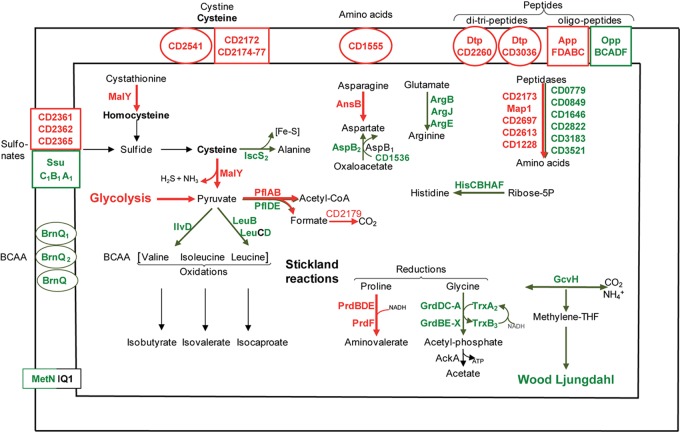
Amino acid transport and metabolism in biofilms compared to planktonic cultures. A model for amino acid transport and utilization pathways in biofilm compared to planktonic cells is proposed. It is based on the expression of genes involved in amino acid transport and metabolism, and drawn as in Figure 2. BCAA, Branched Chain Amino Acids; Fe-S, Iron-Sulfur cluster.